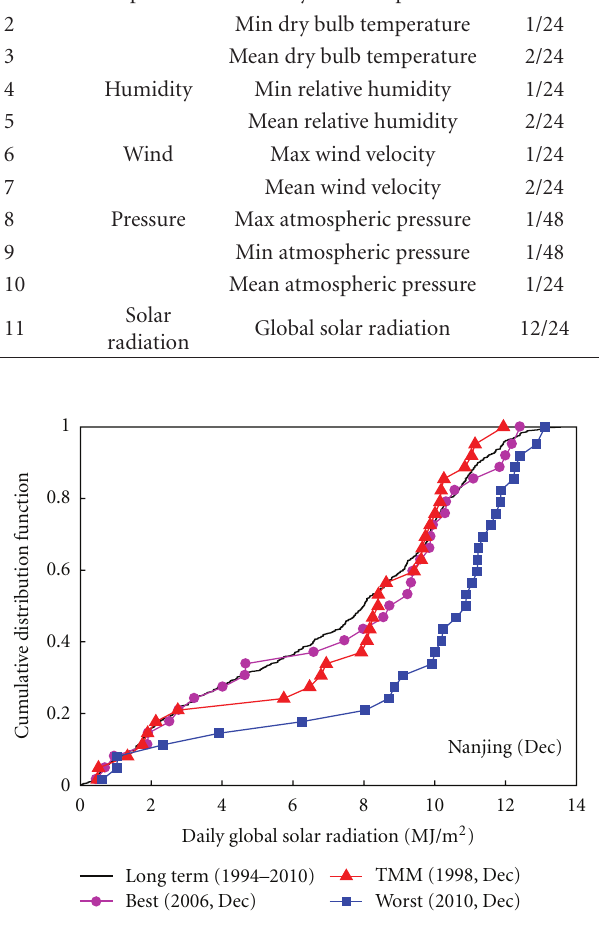
Figure 2: CDFs for December daily global solar radiation for Nanjing.